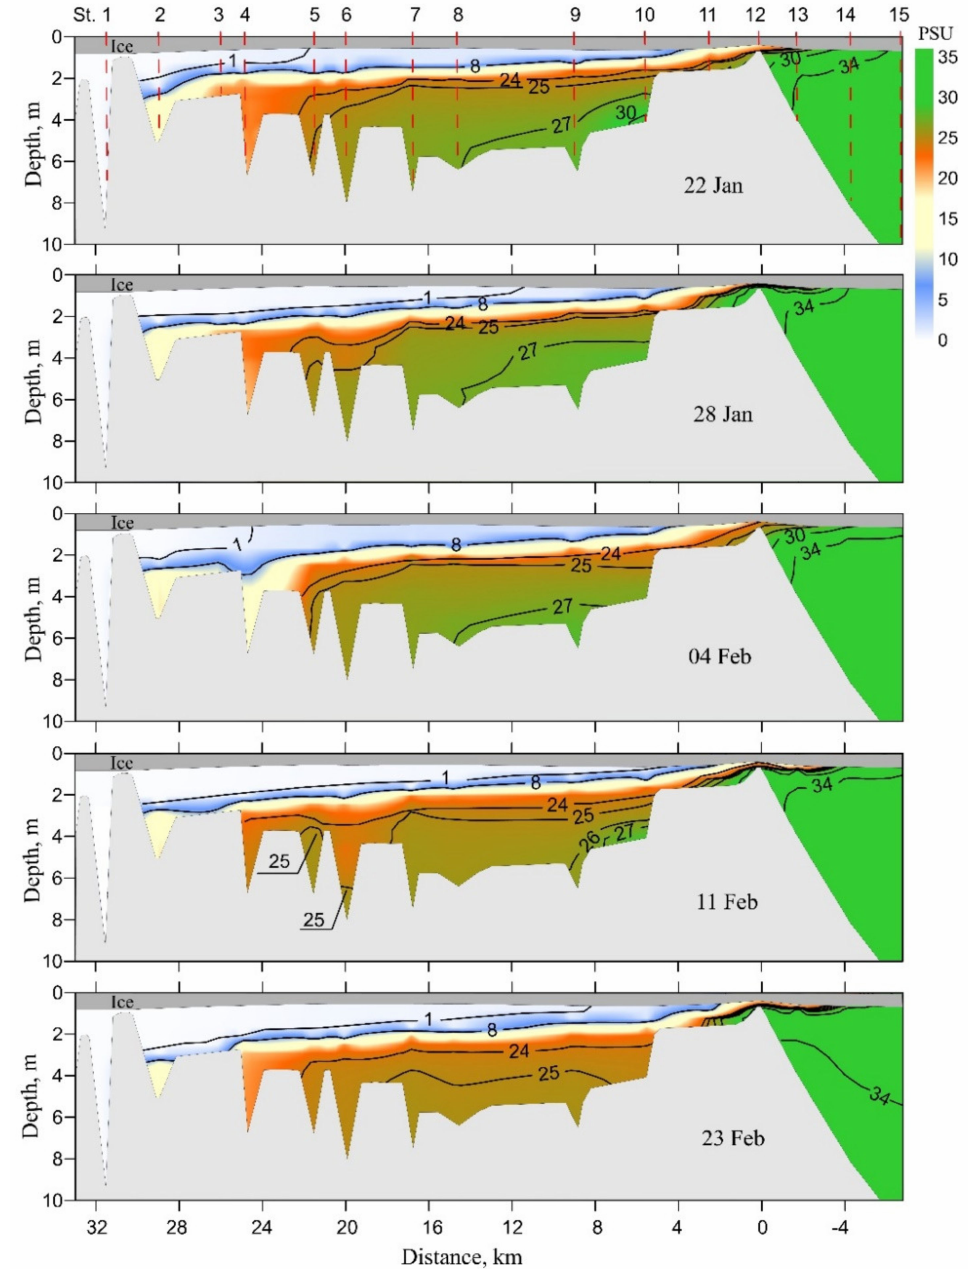
Figure 2. Salinity data on transect obtained from 22 Jan. 2022 to 23 Feb. 2022. The position of monitoring stations is shown by dotted red lines. Positive values on the x -axis—distance from the river mouth bar (St. 12) to upstream, negative values—to